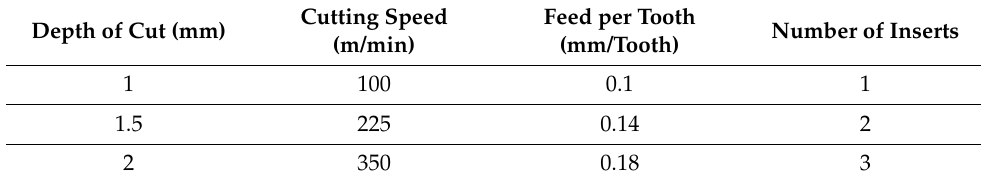
Table 3. Machining parameters and their levels used in this